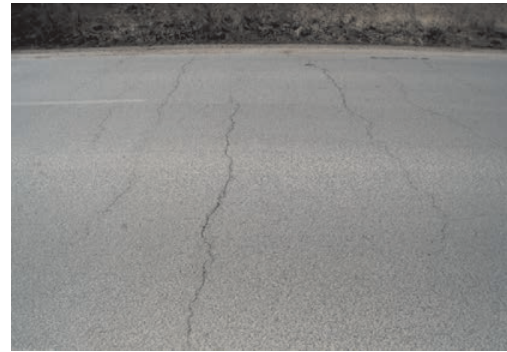
Fig. 9. Transverse cracking in pavement structure with semi rigid surface layer